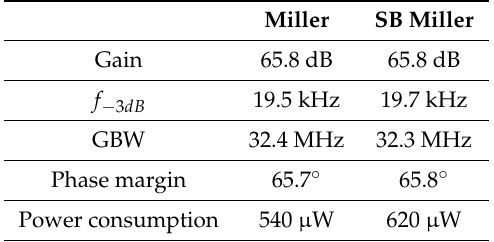
Table 1. AC and DC characteristics of the Miller